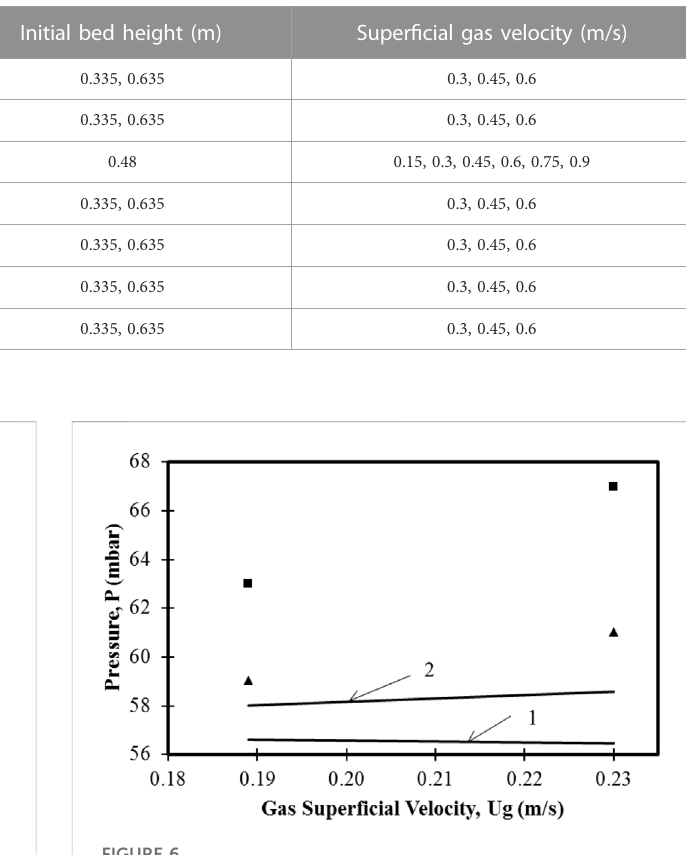
Regime analysis, based on the criteria of Bi and Grace (1995), showing the scope of the present analysis of bubbling and slugging regimes. Large particle percentages and corresponding notations: ◆ — 0% large particles; ▲ — 20% large particles; ■ — 40% large particles; × — 60% large particles; C — 80% large particles; and + — 100% large particles.